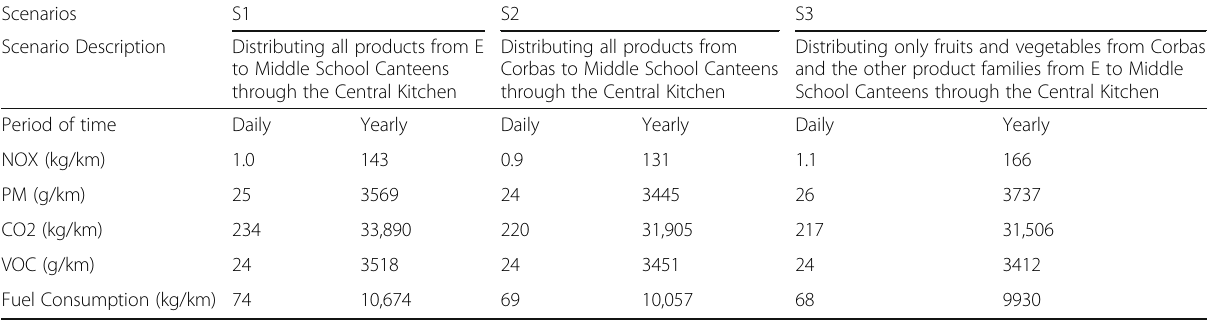
Table 12 The scenarios VRP environmental evaluation results for the 3,5 t vehicle and 14 t vehicle calculated by ANNONA Scenarios